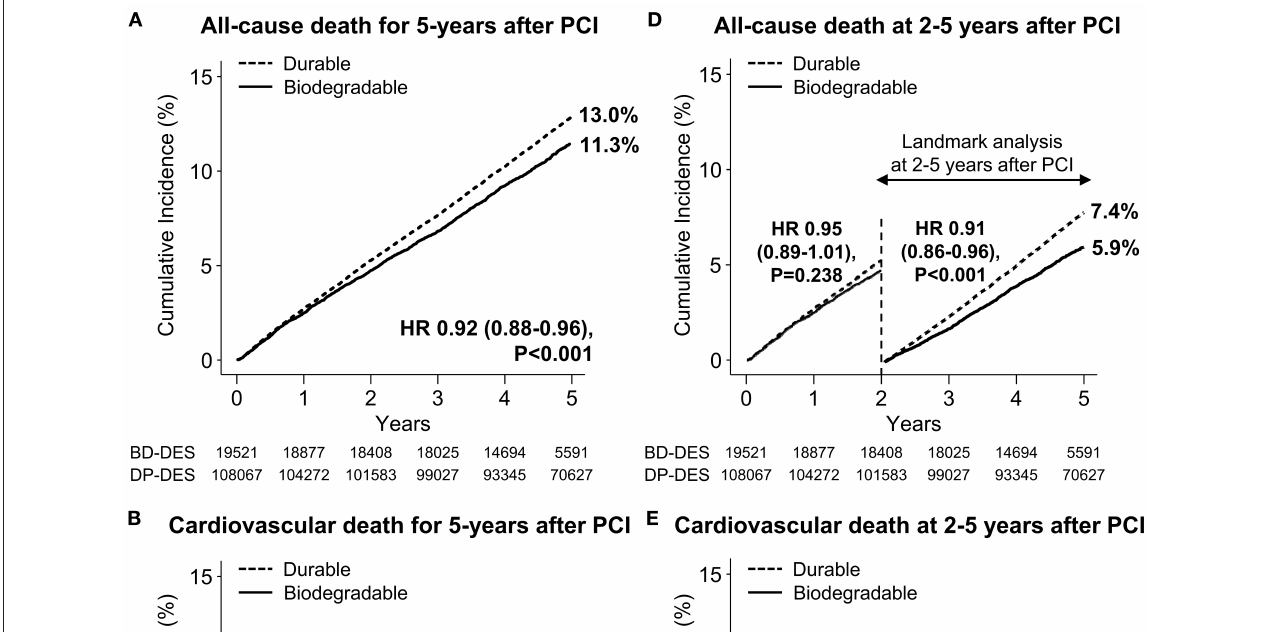
FIGURE 2 | Time-to-event curves for the clinical outcome of interest and landmark analysis between 2 and 5 years after PCI. The cumulative incidence of (A) all-cause death, (B) cardiovascular death, and (C) myocardial infarction for 5 years after new-generation drug-eluting stent implantation. Landmark analyses between 2 and 5 years after index percutaneous coronary intervention for the cumulative incidence of (D) all-cause death, (E) cardiovascular death, and (F) myocardial infarction are presented. BP-DES, biodegradable polymer drug-eluting stent; DES, drug-eluting stent; DP-DES, durable polymer drug-eluting stent; HR, hazard ratio.